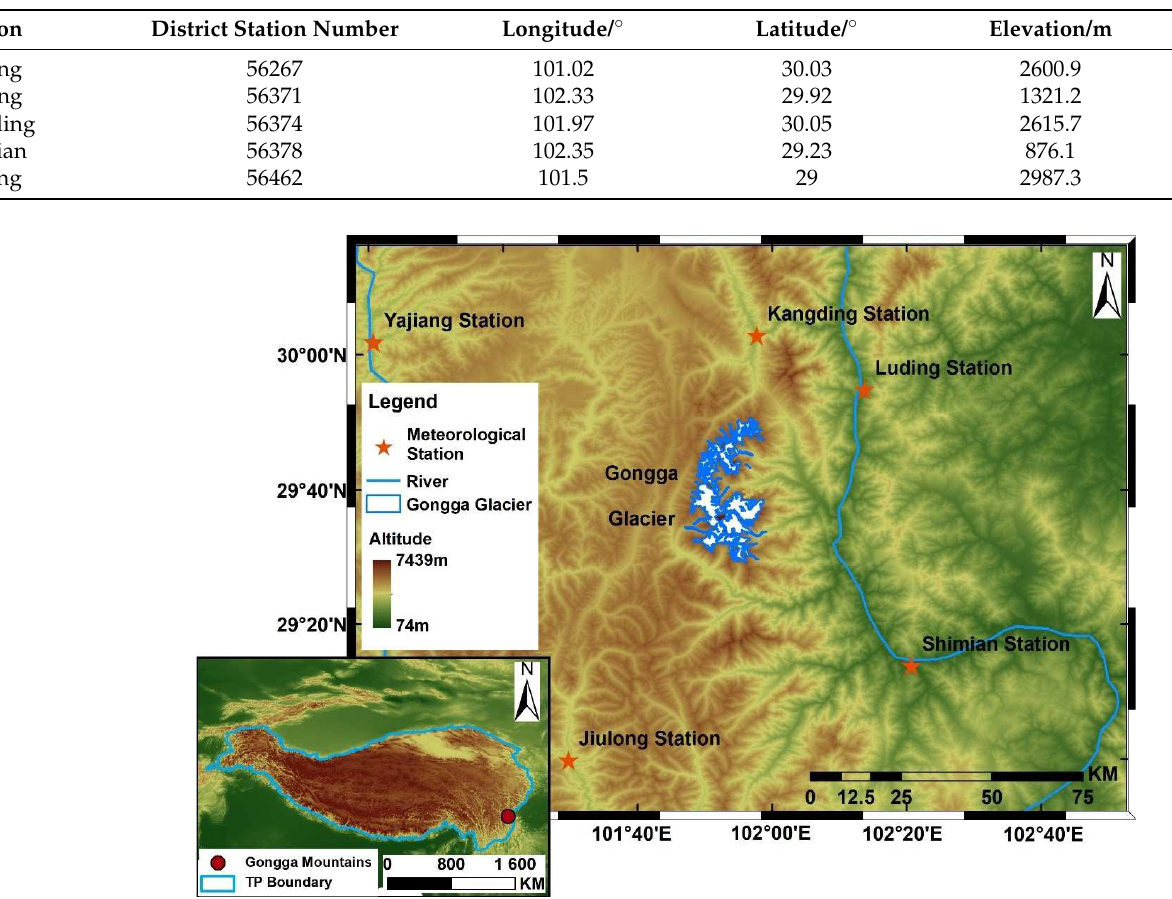
Figure 1. Location of the study area and distribution of meteorological stations. Table 4. Information on meteorological observation